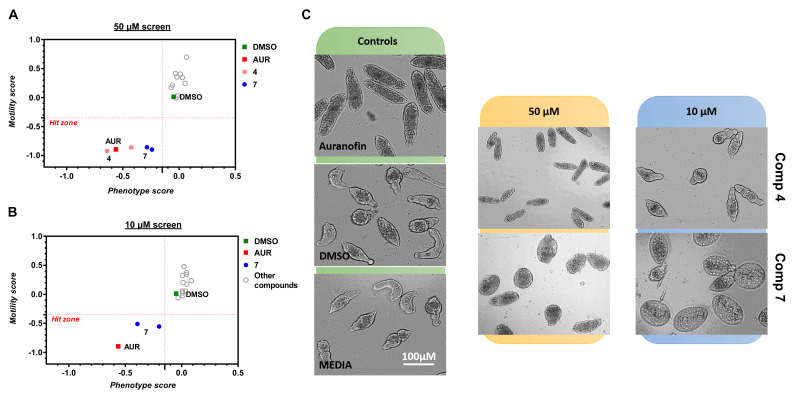
Putative SmMLL-1 substrate-binding pocket inhibitors (set one) affect schistosomula phenotype and motility.Mechanically-transformed schistosomula (n = 120) were incubated with the selected compounds (50 µM -
Panel A - and 10 µM -
Panel B - in 0.625% DMSO; each of them in duplicate) for 72 h at 37°C in a humidified atmosphere containing 5% CO
2. One of three replicate screens is shown here (barcode 0255, Supplementary Table 2,
Extended data
64). Compounds with activity on both schistosomula phenotype and motility are shown within the ‘Hit Zone’ (delineated by the dotted red lines in the graph).
Panel C - Visual representations of schistosomula phenotype induced by compounds 4 and 7. These two compounds were tested on schistosomula at 50 and 10 µM. Each image represents a cropped sample of the schistosomula obtained from hit wells of screen 0255. The brightness of the image has been modified slightly (+ 20%) from the original image to make the differences in phenotype more apparent. Images of control parasites - Auranofin, DMSO and media treated schistosomula - are included for reference.